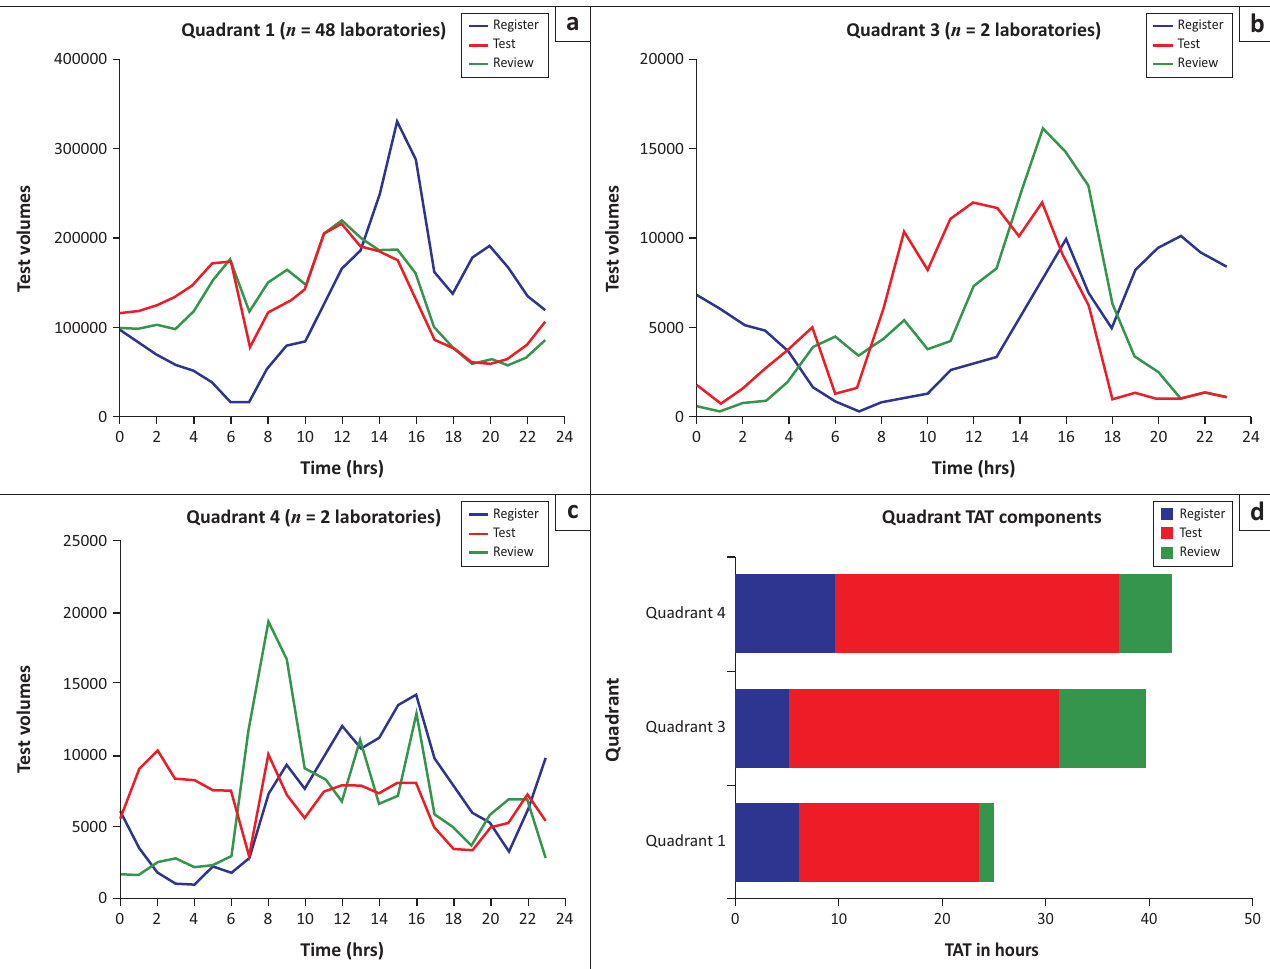
FIGURE 5: (a) Represents the workflow over a 24 h period of all good performing laboratories ( n = 48) versus, (b) a satisfactory performing laboratory (as identified in Figure 4, Q4), (c) Represents two poor performing laboratories, (d) Indicates the breakdown of TAT into registration time in green, testing time in red and review time in